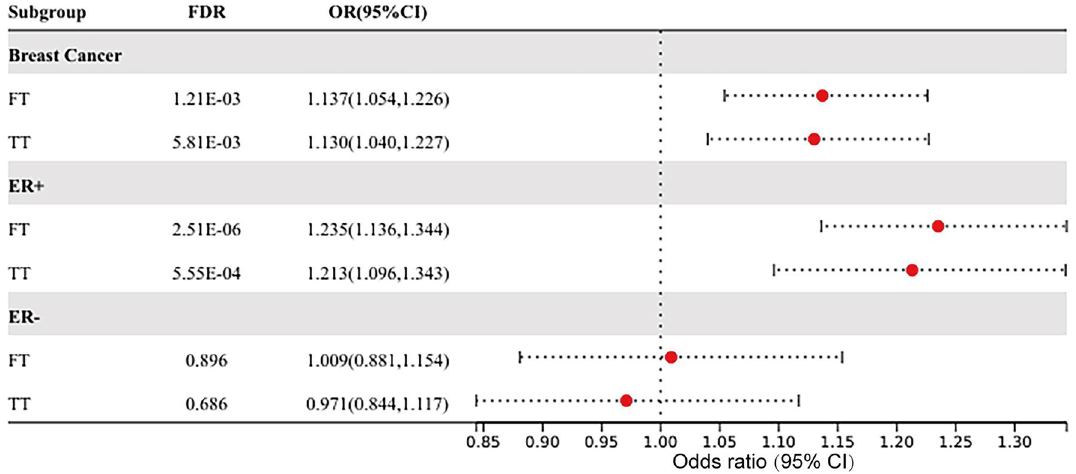
Figure 5. The forest plot of Mendelian randomization results between testosterone levels and breast